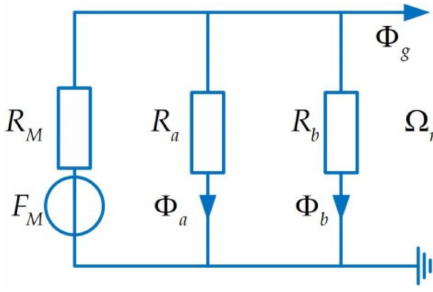
Figure 1. The equivalent magnetic